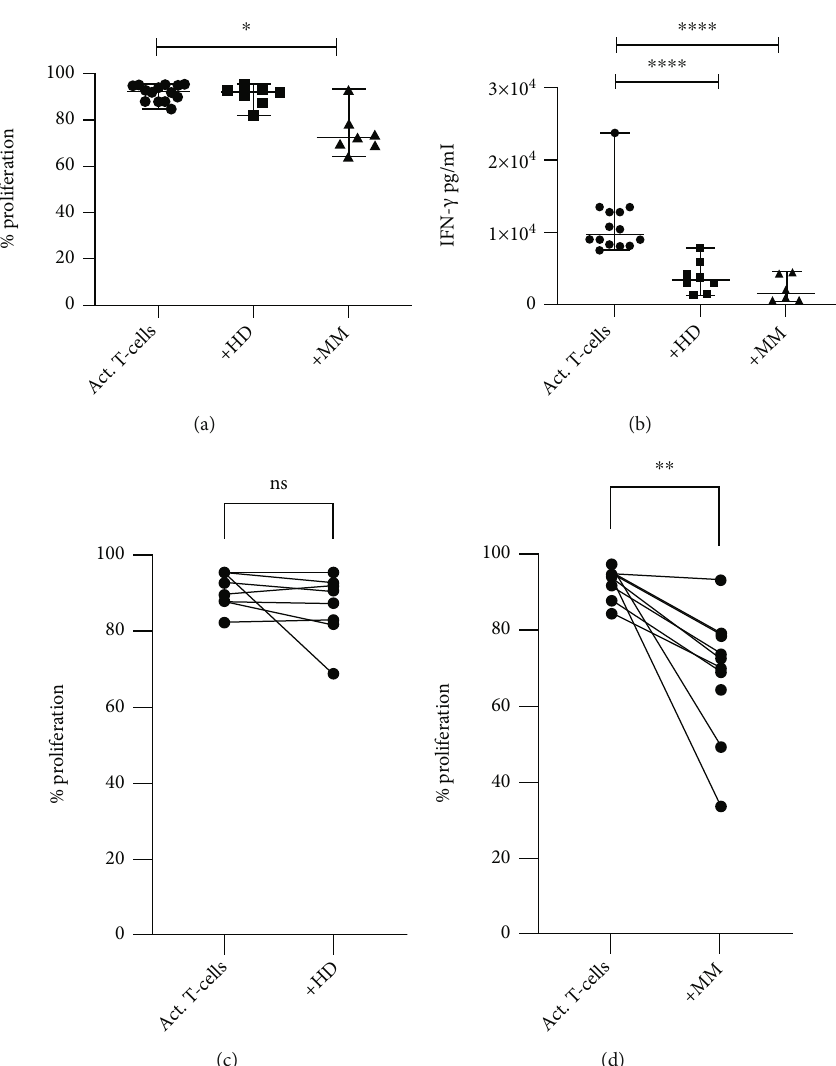
Figure 2: Inhibition of T-cell proliferation and IFN- γ production by bone marrow NDG. (a) Median proliferation for each group is 94% (95% CI: 88 – 95), 91% (95% CI: 82 – 93), and 71 (95% CI: 50 – 79), respectively. The proliferation of T-cells was not inhibited by HD NDG ( p = 0 : 1016 ) but by NDG from MM patients ( p = 0 : 002 ). (b) The median IFN- γ production for each group is 9700pg/ml (95% CI: 8200 – 13500), 3500pg/ml (95% CI: 1450 – 7800), and 1600 (95% CI: 600 – 4500), respectively. Both HD NDG ( p = 0 : 0078 ) and MM NDG ( p = 0 : 0312 ) have the ability to inhibit IFN- γ production. (c) The e ff ect of HD NDG on T-cell proliferation ( p = 0 : 1016 ) di ff ered between +2% and -26% proliferation. (d) Inhibition by NDGs from MM patients ( p = 0 : 002 ) di ff ered between 1.7 and 60%. Error bars indicate median with range. Statistical signi fi cance was tested with Wilcoxon matched pairs signed rank test. Normal density neutrophils become activated by T-cells over